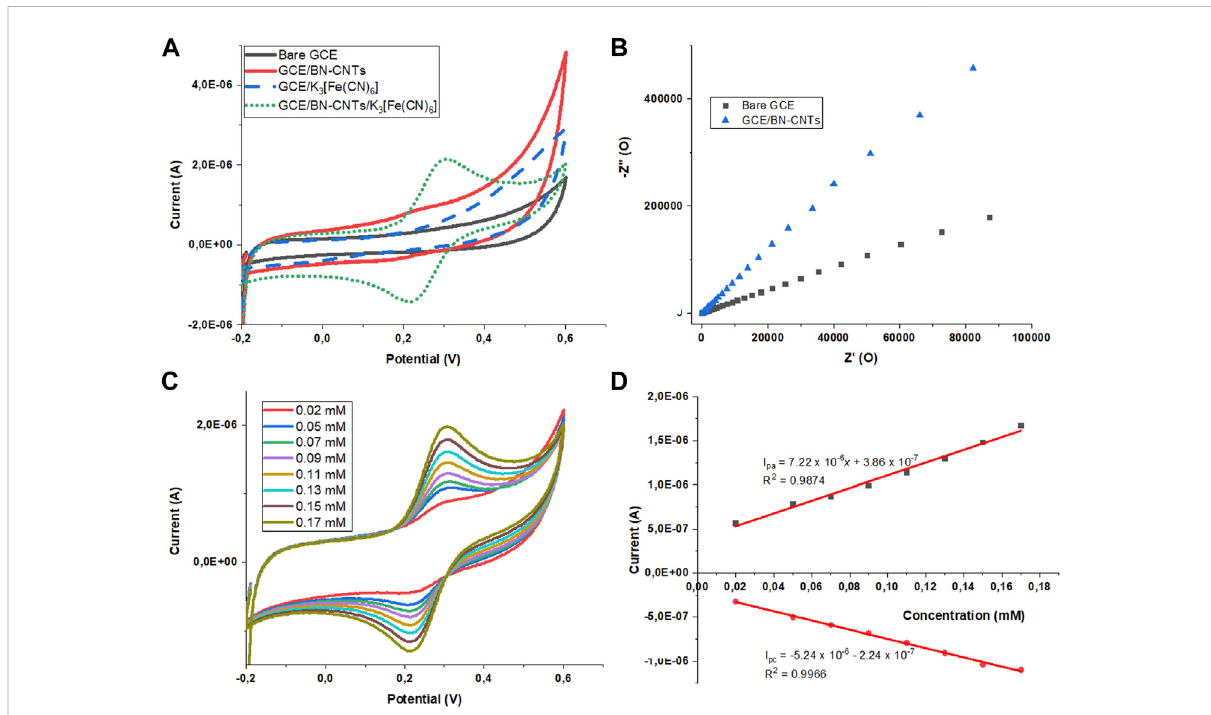
FIGURE 9 Cyclicvoltammetricresponsesobtained beforeandaftertheadditionof0.17 mMpotassiumferrocyanidein0.1 MKOH atthe (A) bareGCEand GCE/BN-CNTs. (B) Nyquist plot of 0.17 mM [Fe(CN) 6 ] 3-/4- at bare GCE and GCE/BN-CNTs. (C) GCE/BN-CNTs varying the concentration of K 3 [Fe(CN) 6 ], and (D) plot of analyte concentration versus current for both anodic and cathodic peaks, with a scan rate of 50